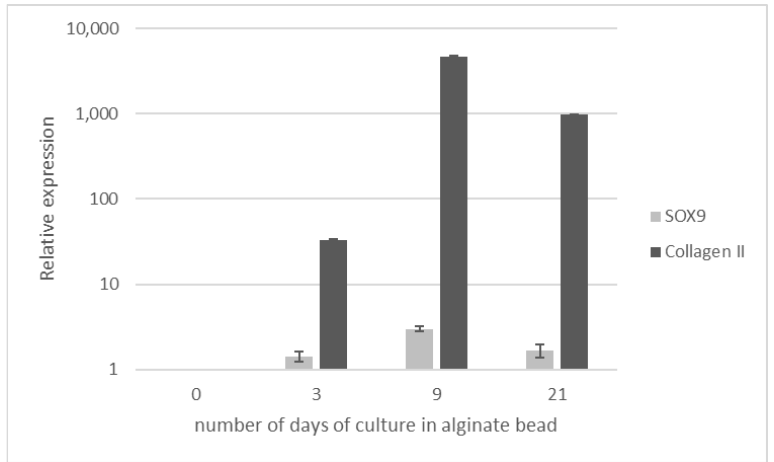
Figure A7. Relative expression of SOX9 and collagen II genes in NHAC-Kn encapsulated in alginate beads (vs. cells grown in monolayers), n = 3. Mean values and standard error are given.